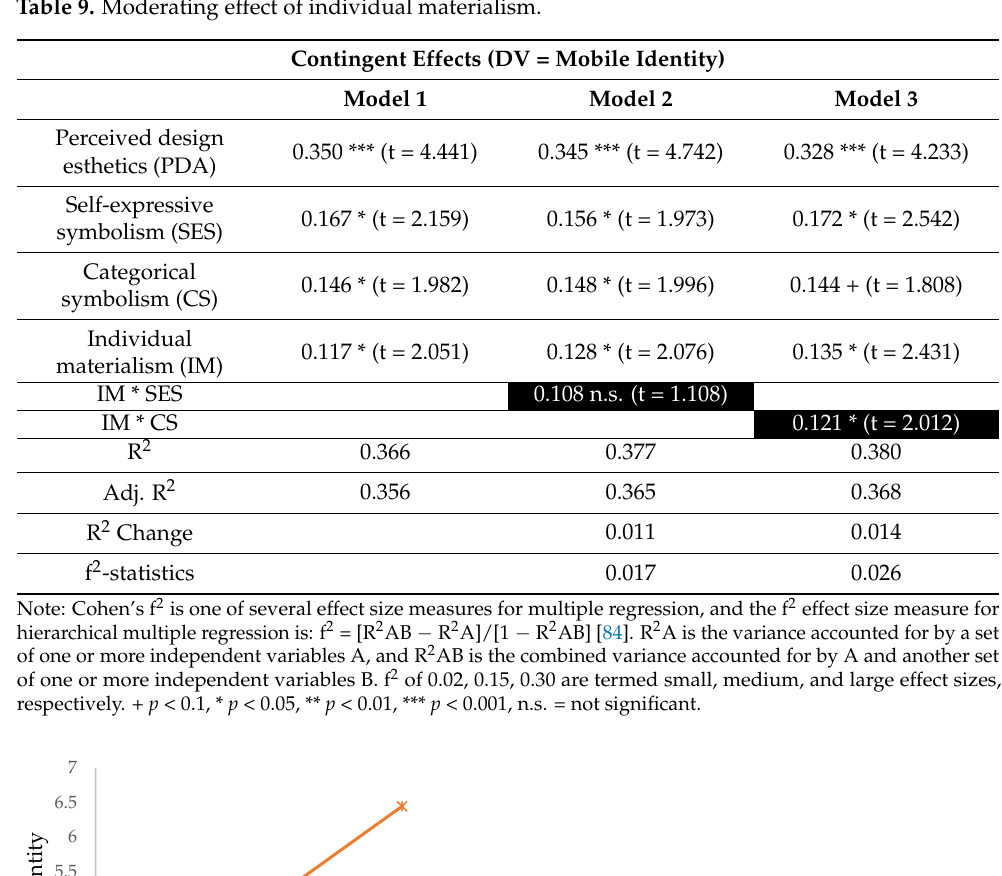
Table 9. Moderating effect of individual materialism.